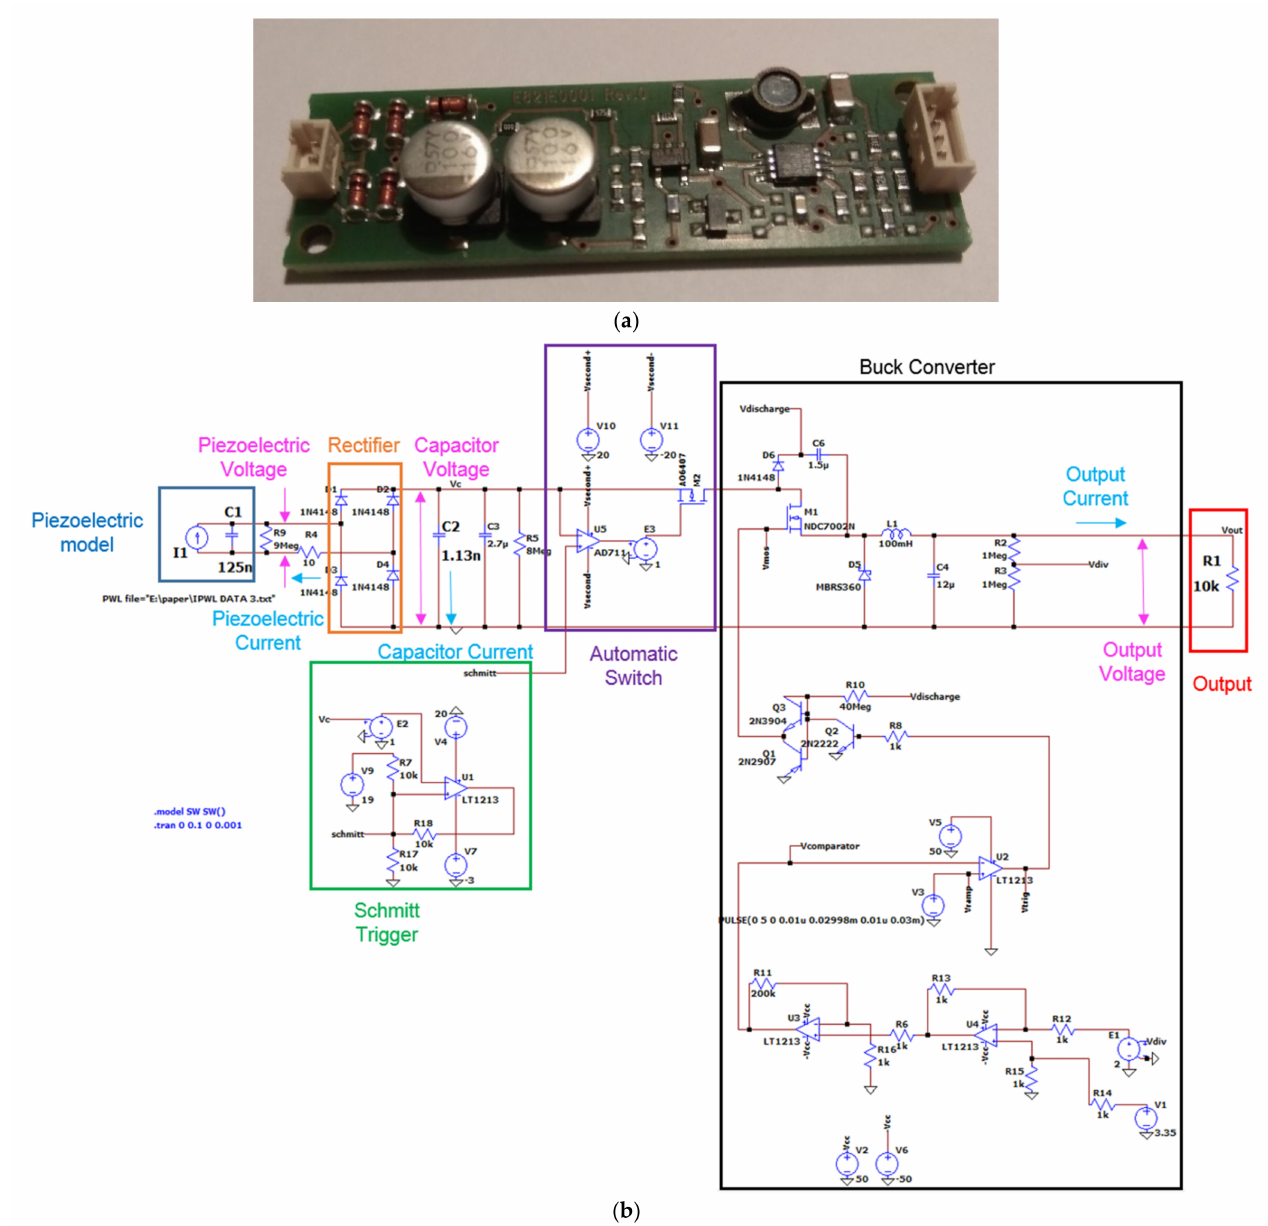
Figure 5. PEH circuit: ( a ) physical item, ( b ) modelling approach in